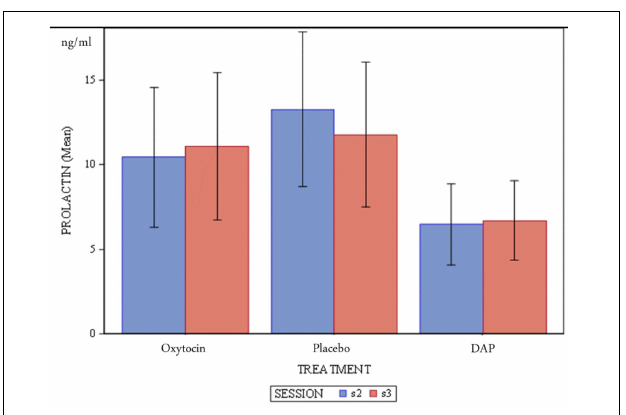
Comparison of Serum Prolactin Levels According to